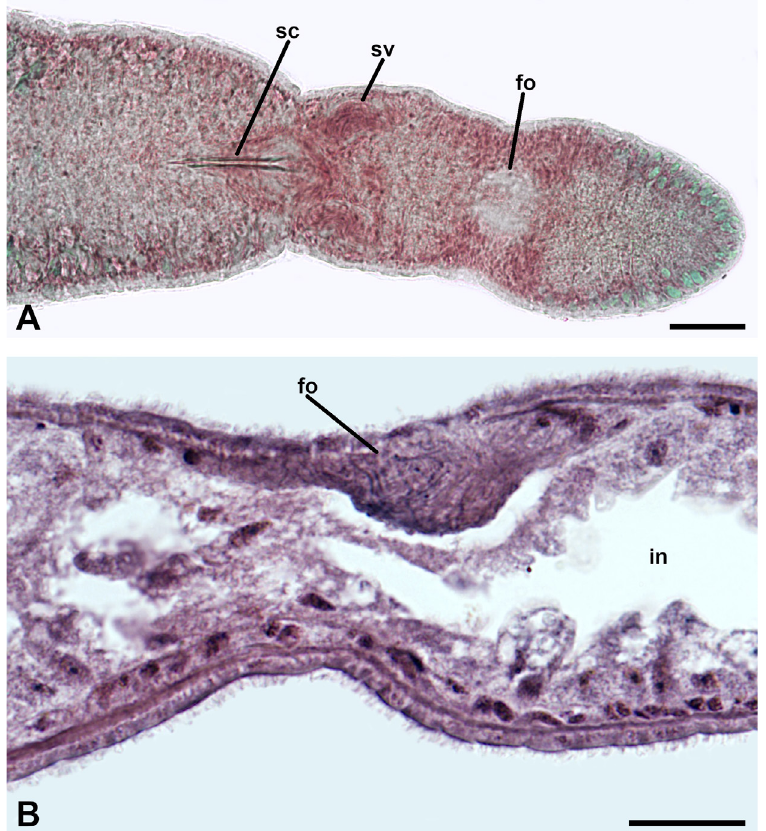
Fig 5. Fibrous organ of Coelogynopora kenichii sp. nov. A . Posterior end of the holotype stained with aceto-carmine and fast green, where the organ is visible as a well-defined, clear area behind the reproductive complex (RMNH.VER.19980.a). B . Sagittal section of a paratype showing the organ above the intestine (RMNH.VER.19980.l). Scale bars: A = 50 µm; B = 20